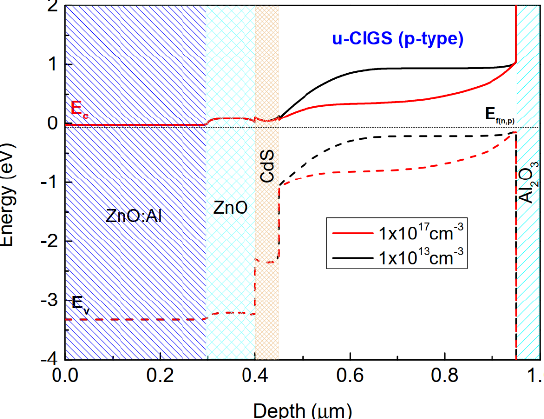
Figure 6. Schematic band diagram of ultrathin CIGS solar cell with two different absorber trap densities under illumination conditions—0 V Bias.